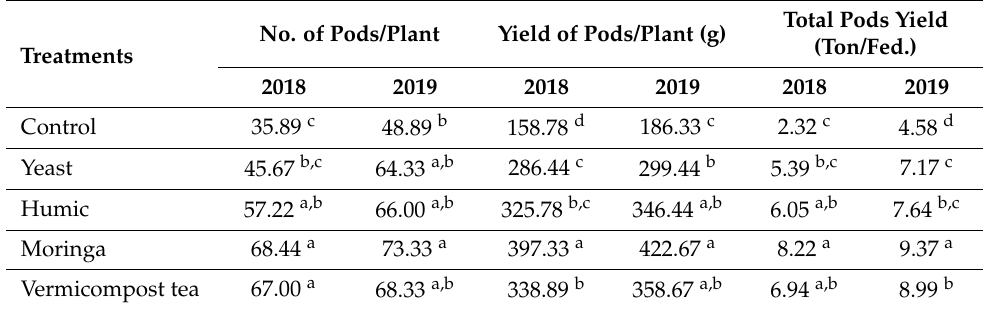
Table 6. Effect of different biostimulant extracts on the number of pods and green bean yield in growing seasons of 2018 and 2019.